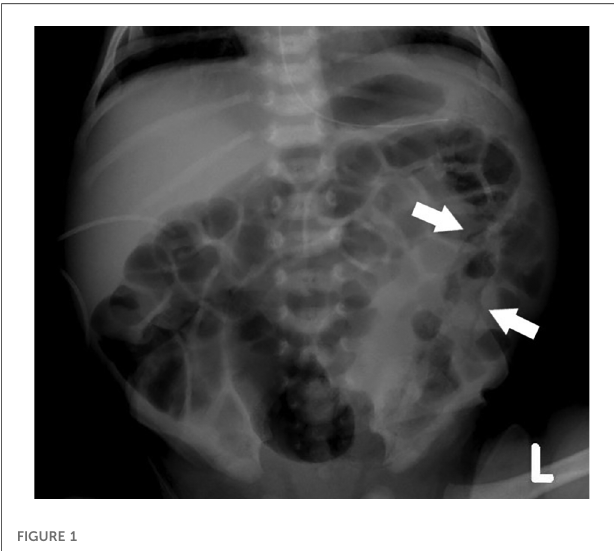
FIGURE 1 Abdominal x-ray demonstrating pneumatosis